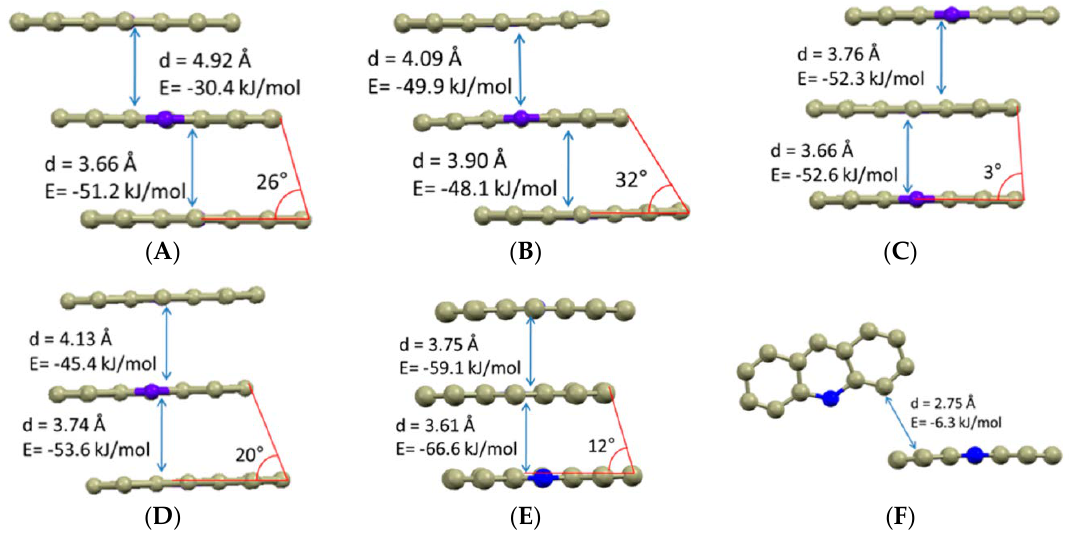
Figure 19. Pictorial representation of π -stacking interaction observed in ( A ) Acridine-2,3 DHBA (1:1) cocrystal, ( B ) acridine-2,4 DHBA (1:1) cocrystal, ( C ) acridine-2,5 DHBA (1:1) cocrystal, ( D ) acridine-2,6 DHBA (1:1) cocrystal, ( E ) acridine-3,5 DHBA (3:1) cocrystal and ( F ) C-H... π interaction observed in acridine-3,5 DHBA (3:1) cocrystal [Reprinted from [17] with permission. Copyright 2018 American Chemical Society].